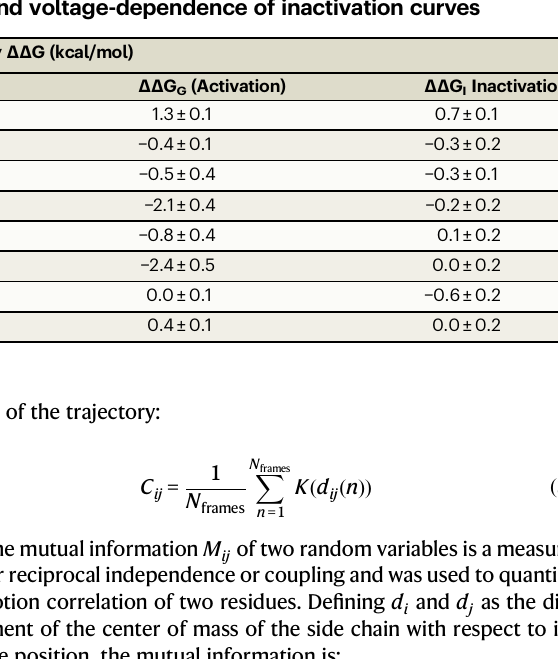
algorithm 41 as implemented in the NetworkX 3.0 library 66 . A step-by-